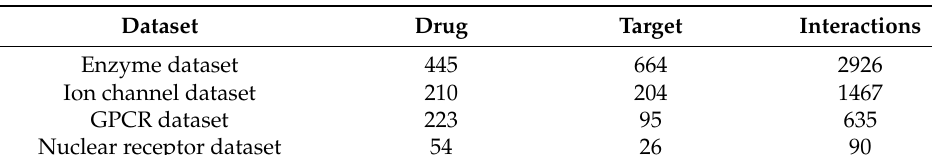
Table 1. Details on the datasets.